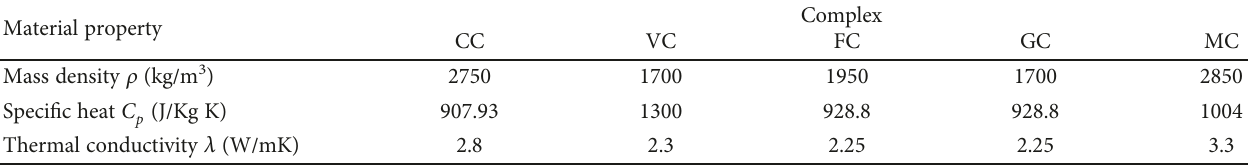
Table 1: Thermal and state parameters adopted in the numerical